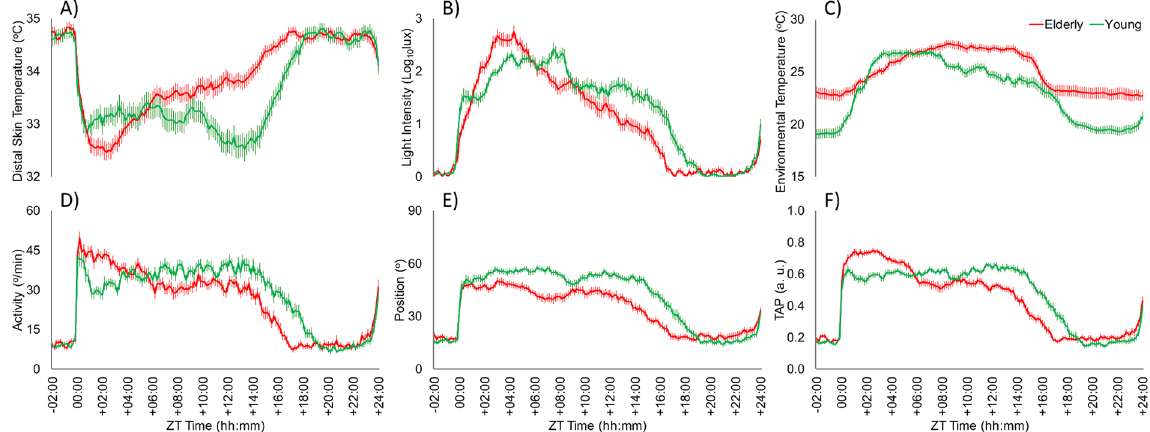
Figure 2. Mean-waveforms standardized for sleep offset for young (green line, n: 44) and aged participants (red line, n: 44) for: ( A ) distal skin temperature, ( B ) light exposure, ( C ) environmental temperature, ( D ) activity, ( E ) body position and the ( F ) the integrated variable TAP. All variables are expressed as the mean ±